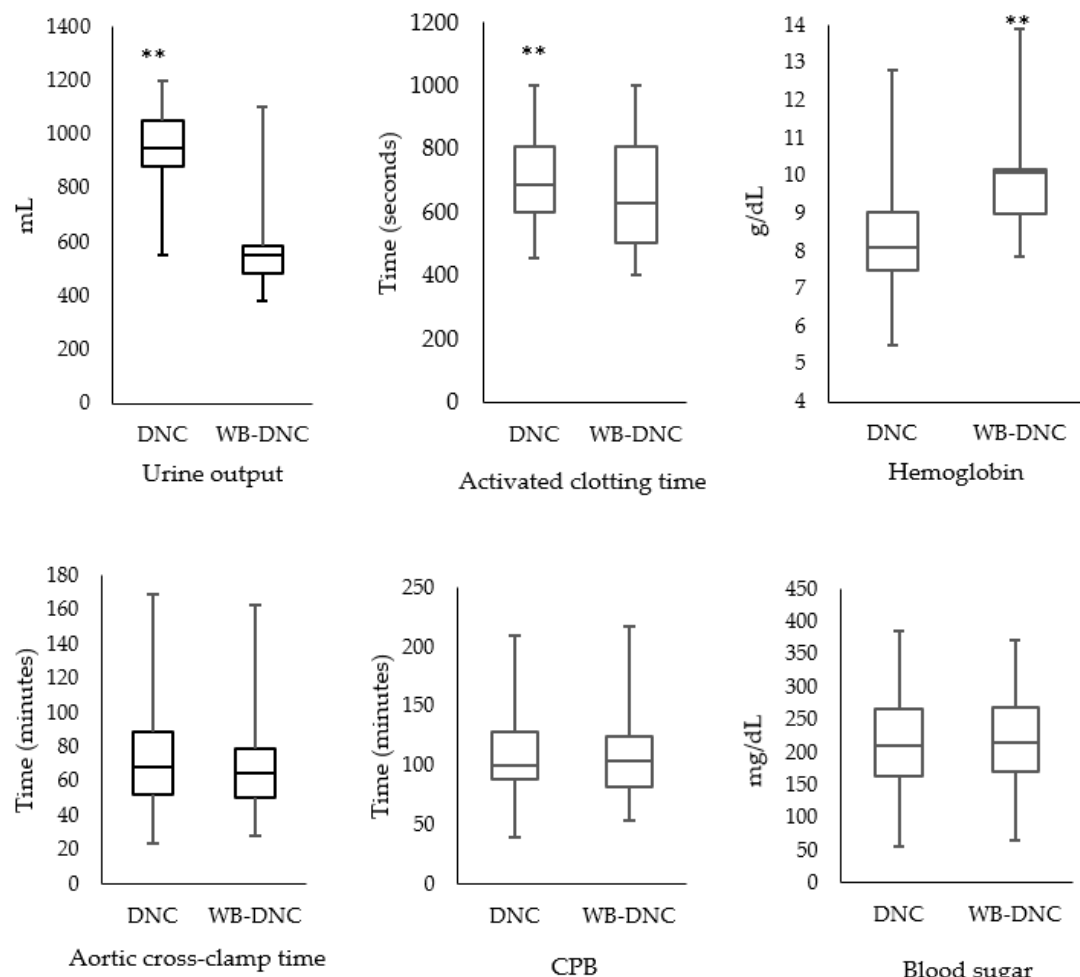
Figure 2. Peri-operative values of urine output, activated clotting time, hemoglobin concentration, aortic cross-clamp time, cardiopulmonary bypass time (CPB), and blood sugar in patients who were either administered Del Nido cardioplegia (DNC) or whole blood (WB)-DNC during CPB. ** represent significant levels at p < 0.01.